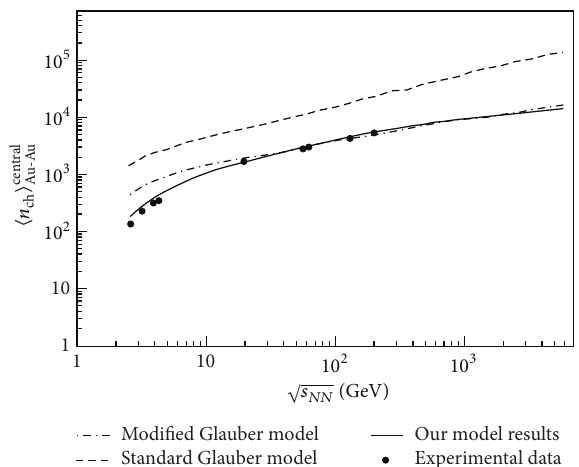
Figure 3: Variations of total mean multiplicity of charged hadrons in central Au-Au collisions with √𝑠 𝑁𝑁 . The figure is taken from [41].